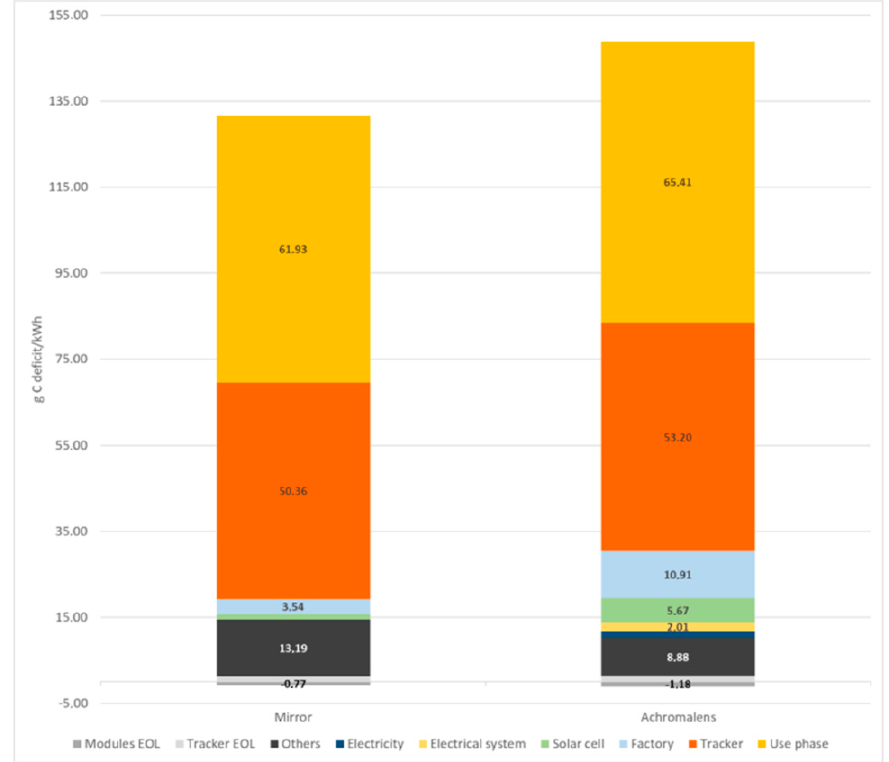
Figure 4. Land-use impact distribution for the mirror and the achromatic lens systems. The mirror system impact is 131.3 g C deficit. However, the achromatic system impact is 147.8 g C deficit. All processes contributing to more than 5% are detailed. Less significant processes are gathered in the “Others” category. Small benefits from recycling metals (gold in particular) explain the negative impact from the modules’ end-of-life.